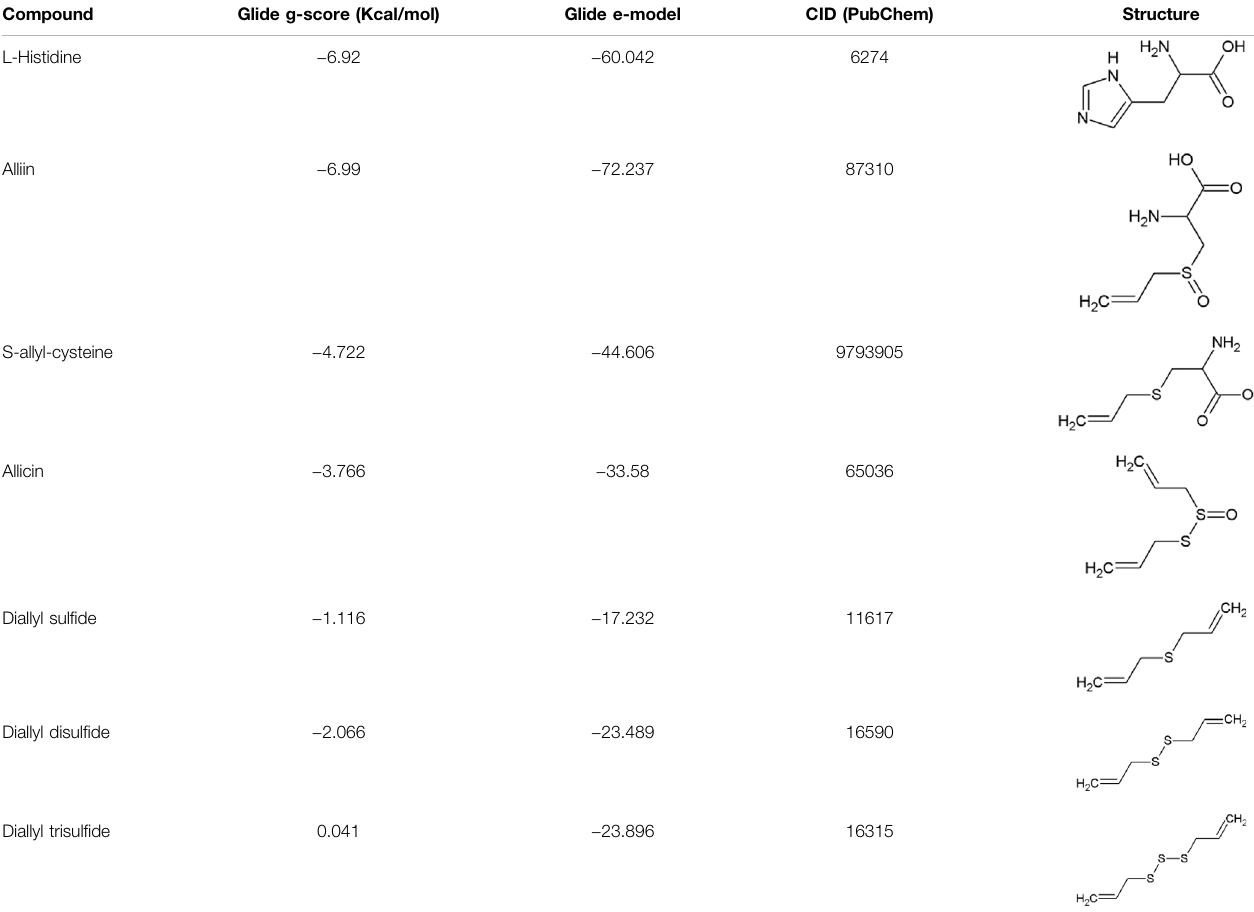
TABLE 1 | Binding af fi nities derived from docking analysis.